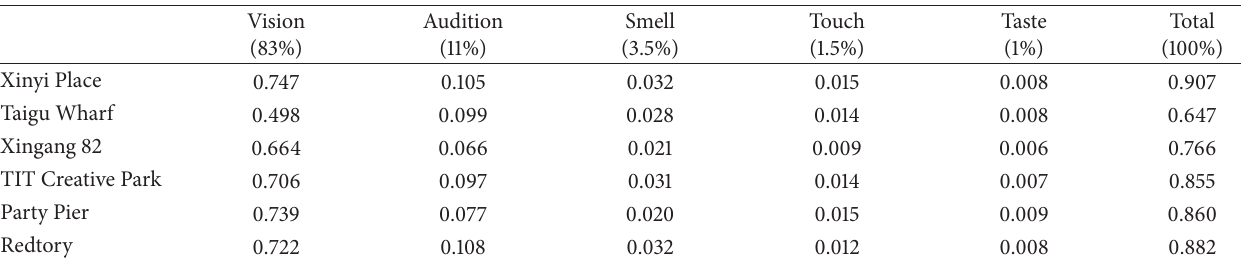
Table 3: The aesthetic performance values of six